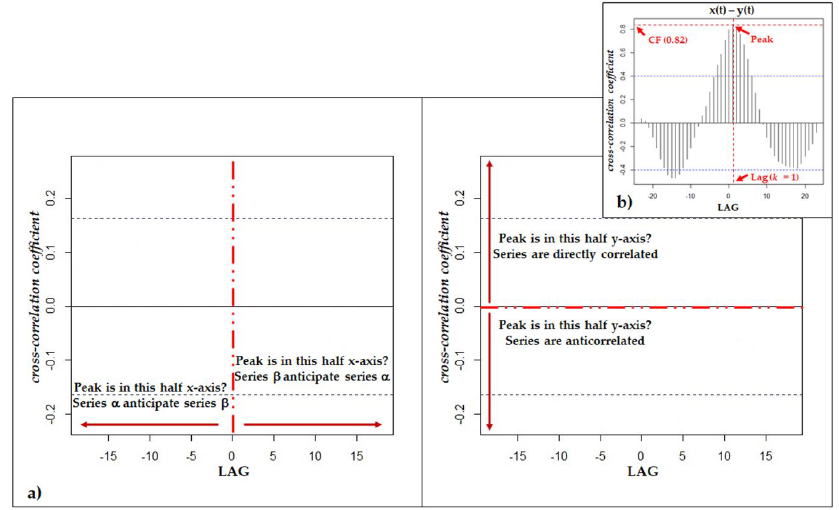
Figure 4. Sketch explaining how to read the correlogram and the interpretation of the peak ( a ) and an example of a correlogram obtained with R software ( b ). On the y-axis is shown the cross-correlation coe ffi cient value and on the x-axis is shown the LAG value: y(t) anticipates the x(t) of a LAG time equal to 1 (that corresponds to the sampling step of the series) ( b ). The dashed lines indicate the values of statistical significance of the